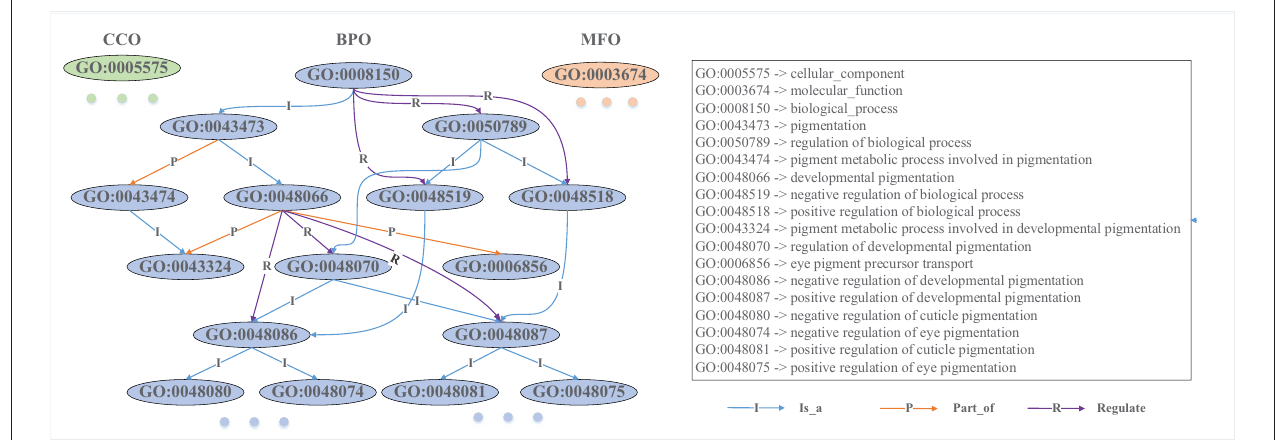
FIGURE 1 | Snapshot of a directed acyclic graph from Gene Ontology. Each ontological term is represented by an alphanumeric identifier, and its biological function is described by controlled words. These GO terms are hierarchically connected with different types of directed edges. The level of a GO term in the DAG is determined by its furthest distance to the root GO term (“GO:0008150” in BPO, “GO:0005575” in CCO, and “GO:0003674” in MFO). For example, “GO:0048087” is a direct child and also a grandson of “GO:0048066,” and its furthest distance to the root term is 5, while “GO:0006856” is another direct child of “GO:0048066” and its furthest distance to the root is 4, so “GO:0006856” is plotted at a higher level than